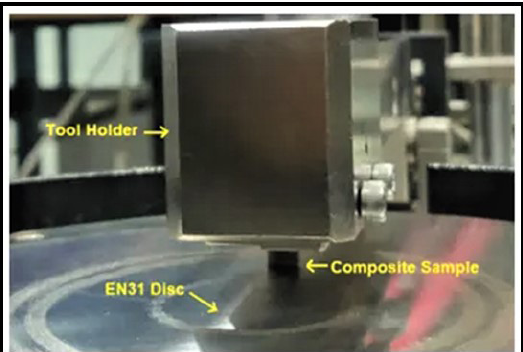
Figure 2. Tribometer